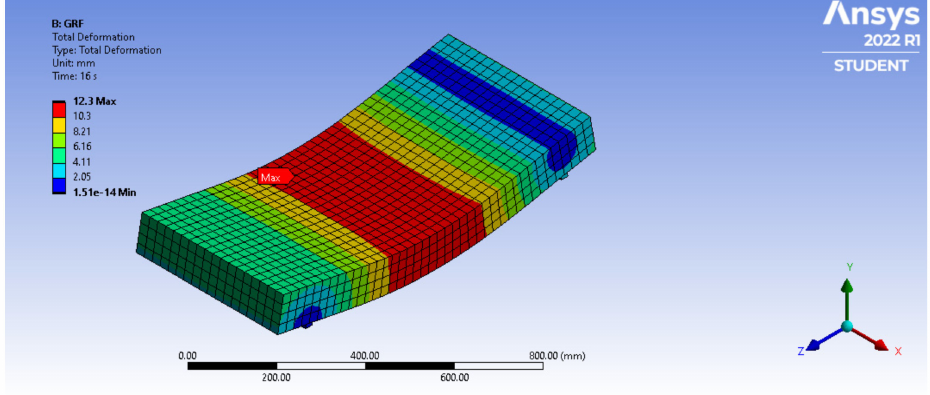
Figure 18. Ultimate deflection of GRF slab.